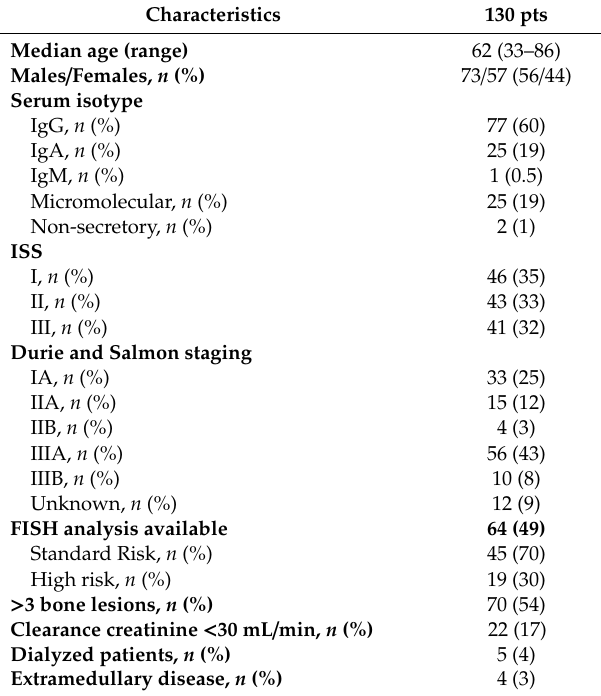
Table 1. Patient characteristics of 130 relapse and refractory multiple myeloma (RRMM) candidates to carfilzomib, lenalidomide and dexamethasone (KRd) as salvage regimen in a real-life